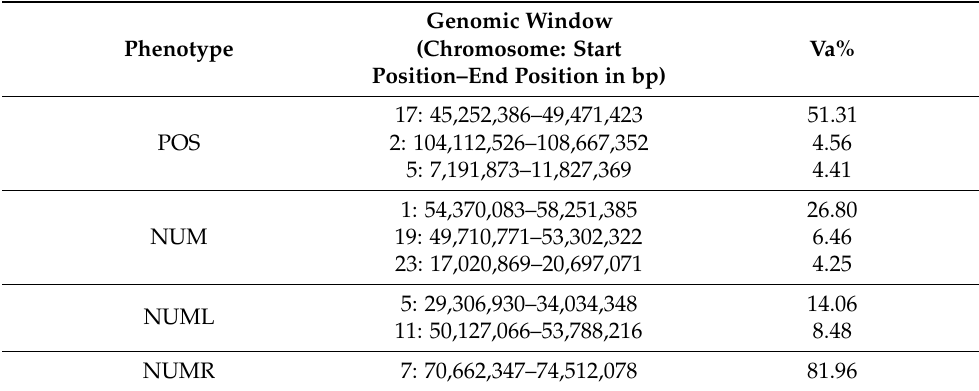
Table 2. Genomic windows and percentage of additive genetic variance (Va%) in the four hair whorl phenotypes explained by each